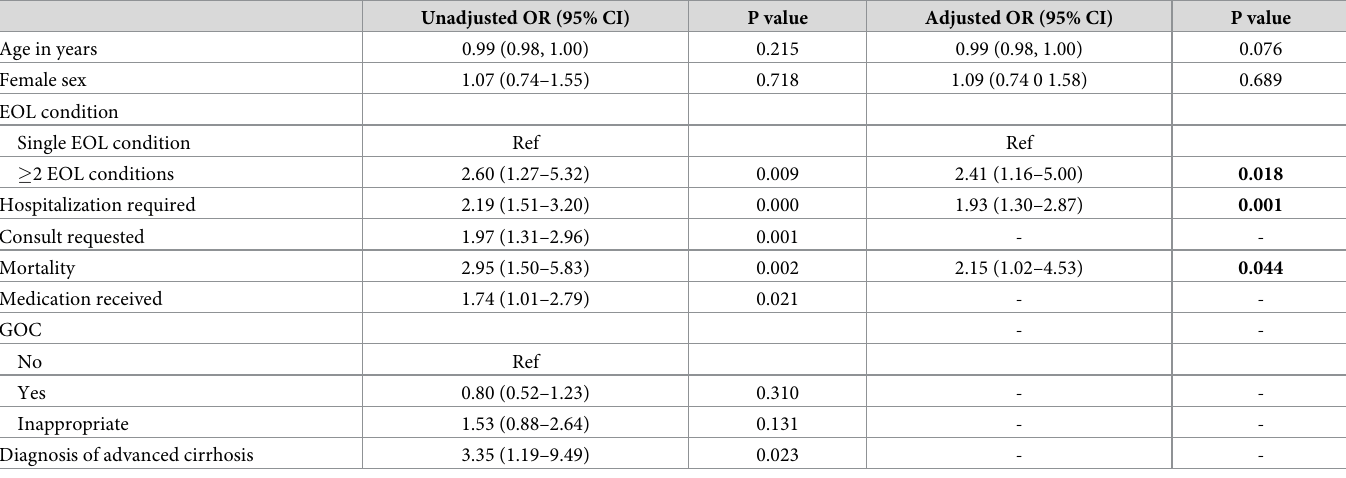
Table 5. Factors associated with having unmet palliative care needs among 663 presentations to the emergency department by patients with end-of-life